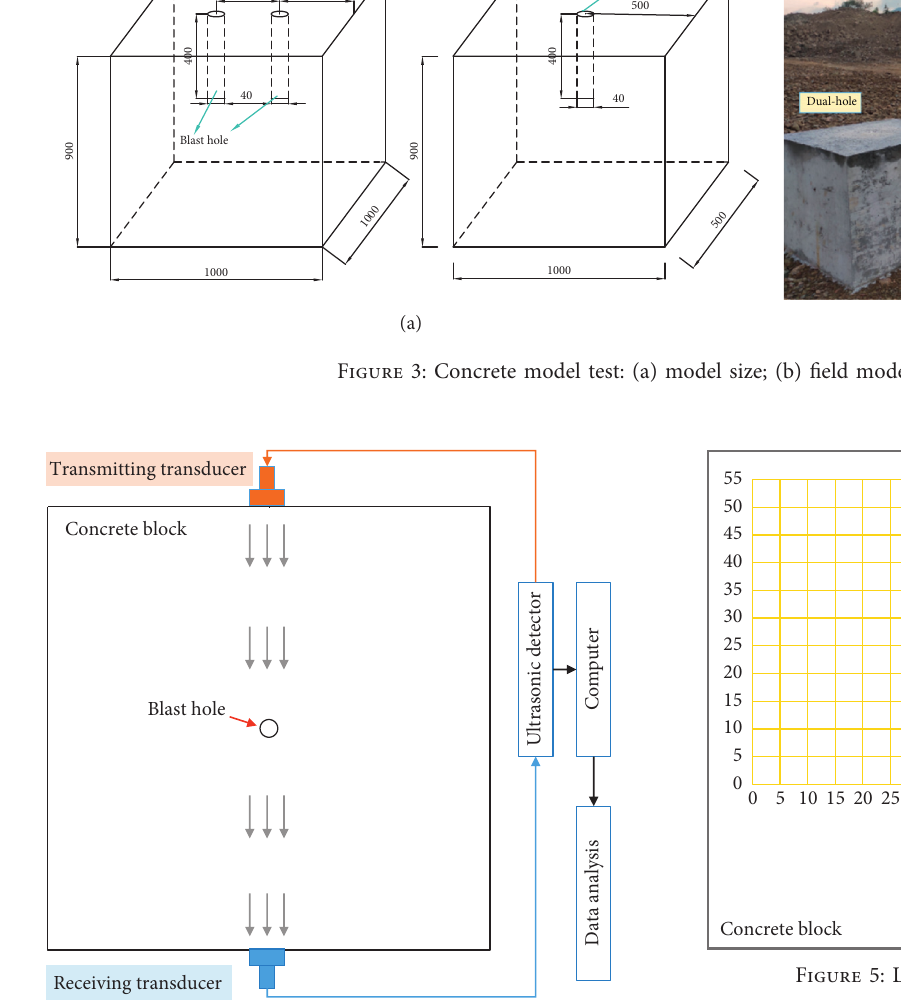
Figure 4: Ultrasonic testing system.